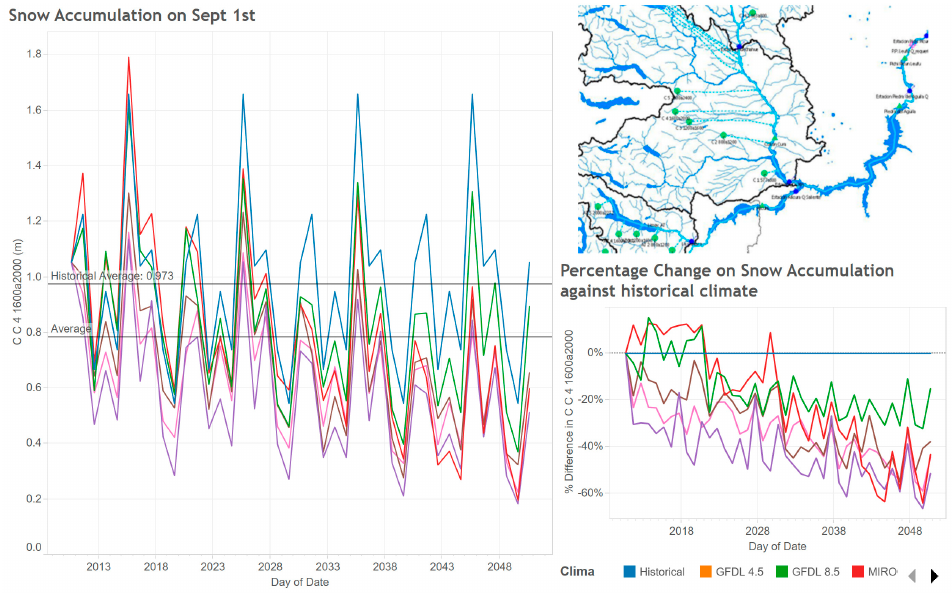
Figure 4. Impacts of climate change on snow pack during the first month of the water year. Table 5. List of Strategies (L) identified for the study area and corroborated by the local institutions.